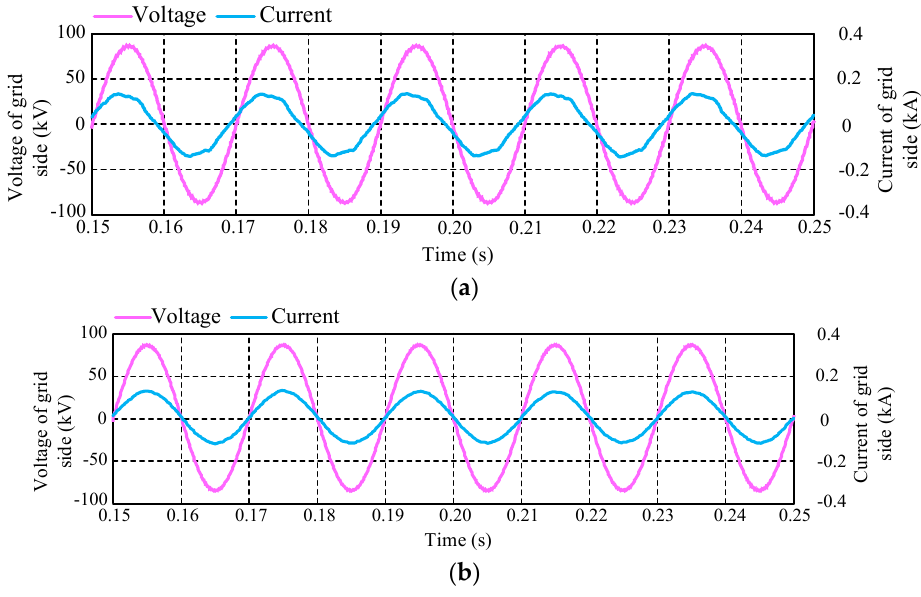
Figure 17. Voltage and current in the grid side of the new grid-connected transformer. ( a ) Without compensation; ( b ) With compensation. Energies 2016 , 9 , 302